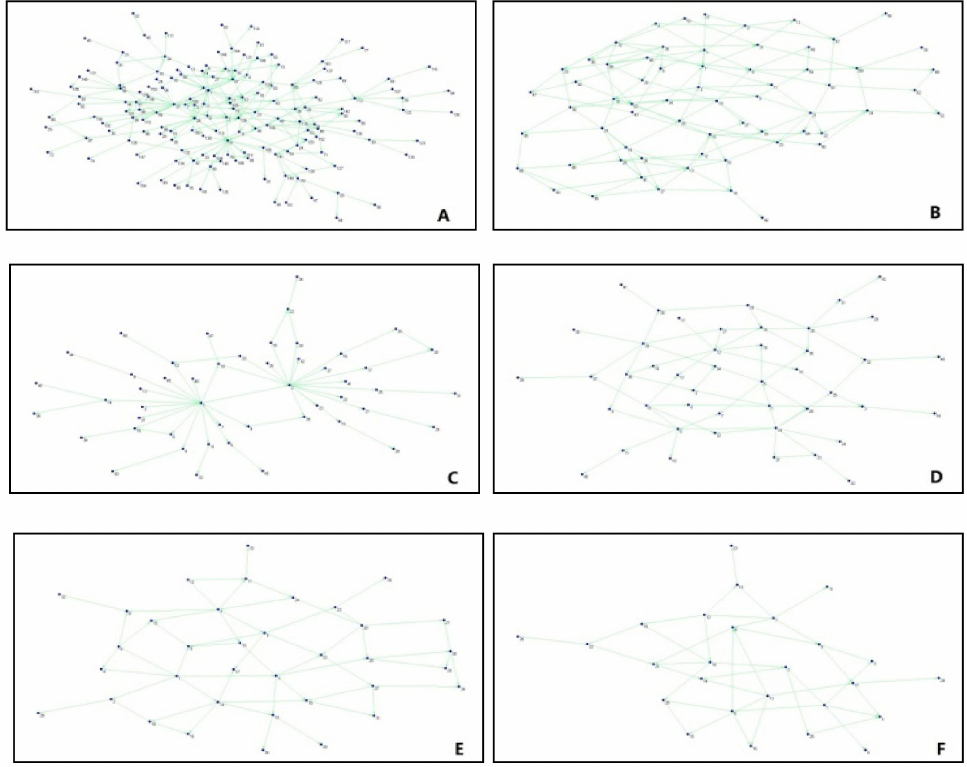
Figure 5. Network Structures of Cohesive Subgroup of Tianjin